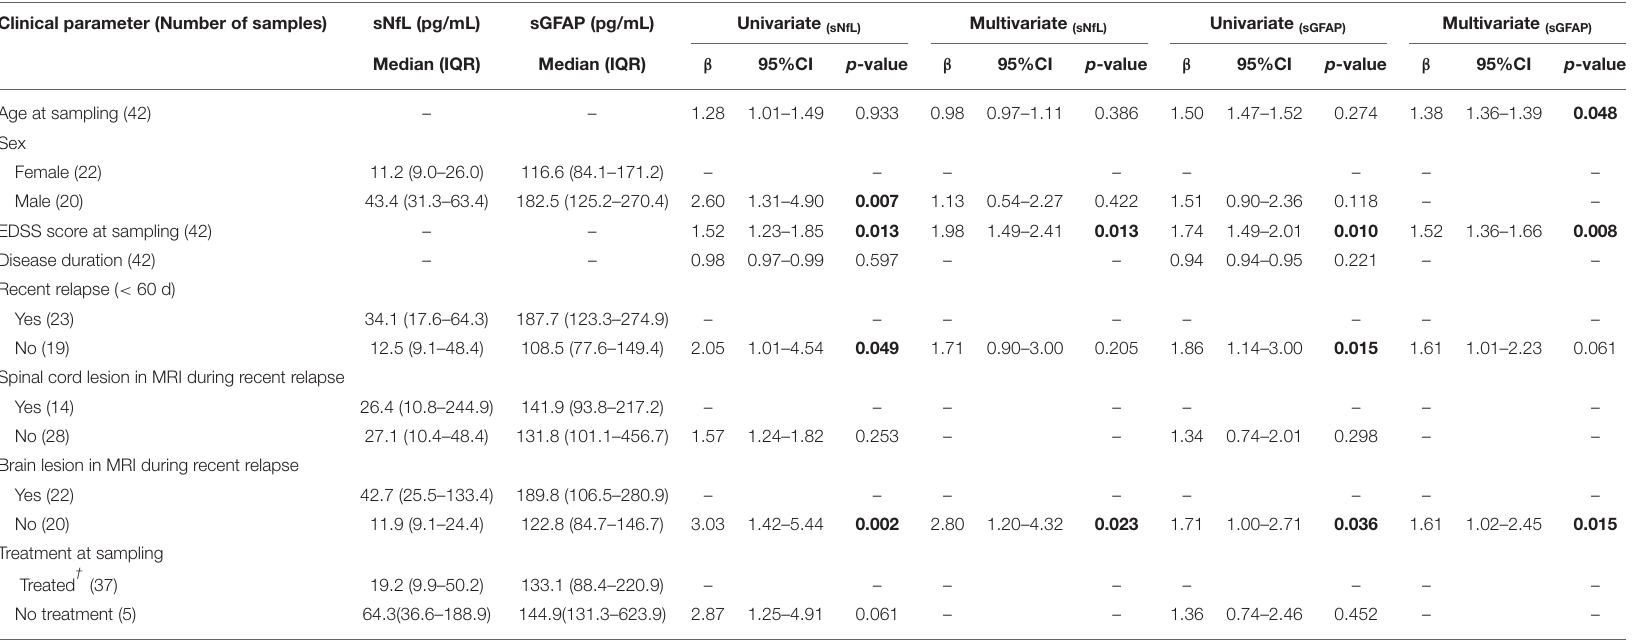
† means usage of steroid and/or immunosuppressant (includes oral immunosuppressant and rituximab). The p-values lower